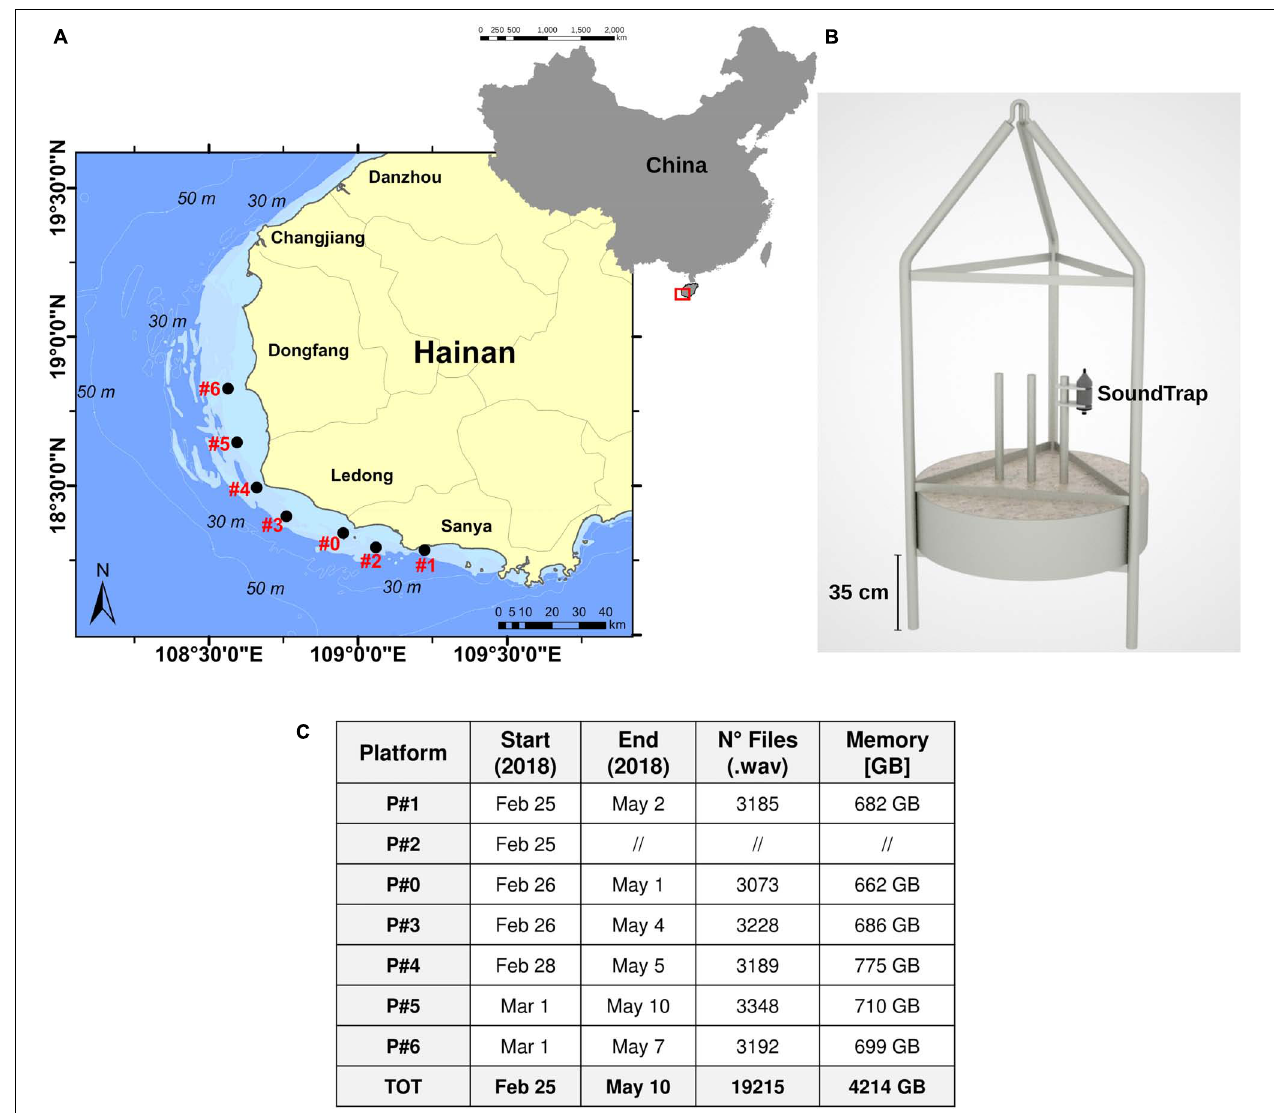
FIGURE 1 | PAM sites and platforms. (A) Map of the locations of the PAM sites. (B) Image of a PAM platform. The acoustic recorder (SoundTrap) was deployed at the center of the frame with a latch system. (C) Table reporting data acquisition information (monitoring period, number of files, storage). The frame P#2 was lost during the